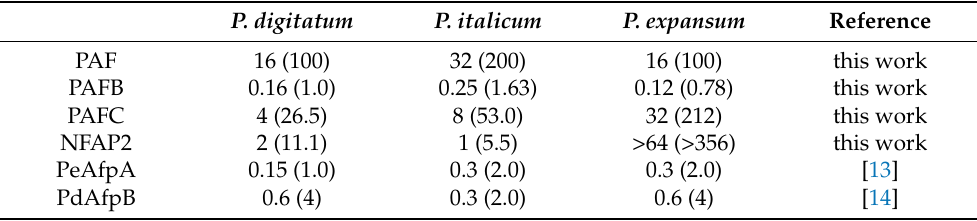
Table 2. In vitro minimum inhibitory concentrations (MICs) of AFPs against Penicillium species 1 . P. digitatum P. italicum P.